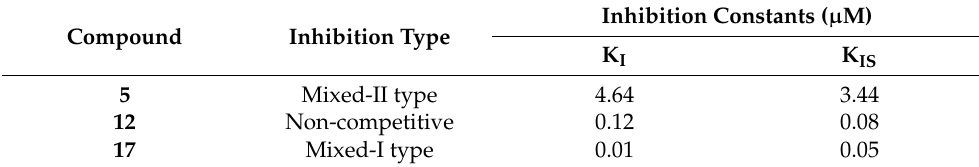
Table 2. The inhibition type and constants of active curcuminoids on mushroom